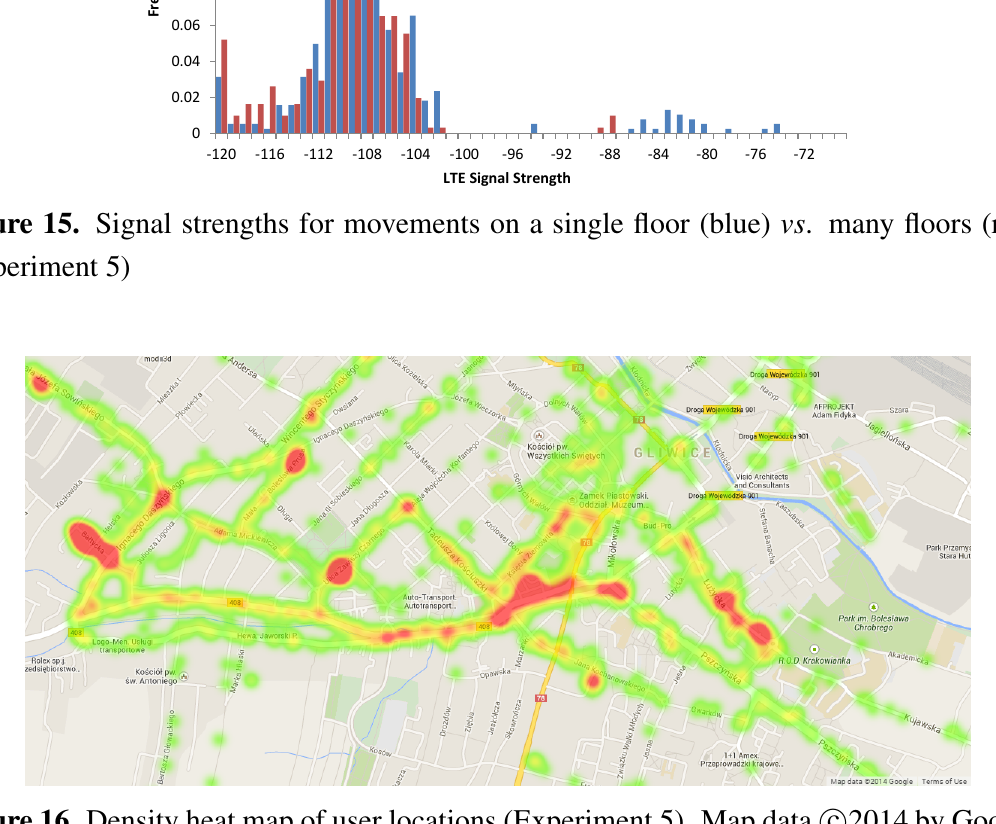
Figure 16. Density heat map of user locations (Experiment 5). Map data c (cid:13) 2014 by Google. (6) Experiment 6: The experiment visualizes real LTE signal strengths measured around the center of Gliwice. The resulting heat map is presented in Figure 17. The area is similar to the density heat